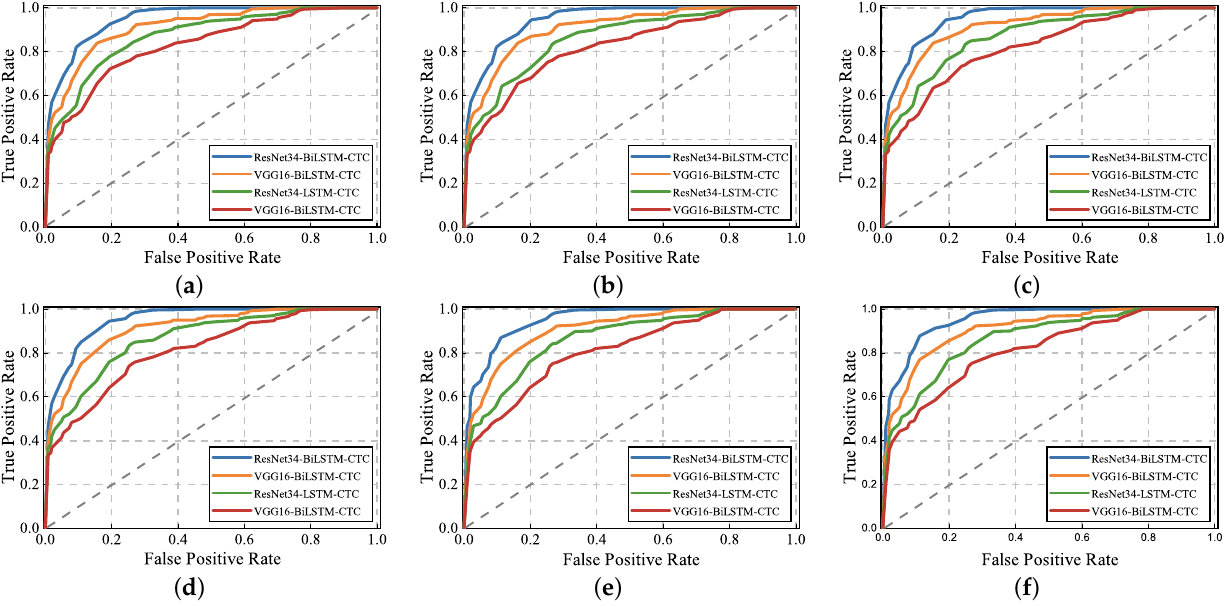
Figure 15. Impact of classification model on sign language gesture performance. ( a ) I am a teacher.